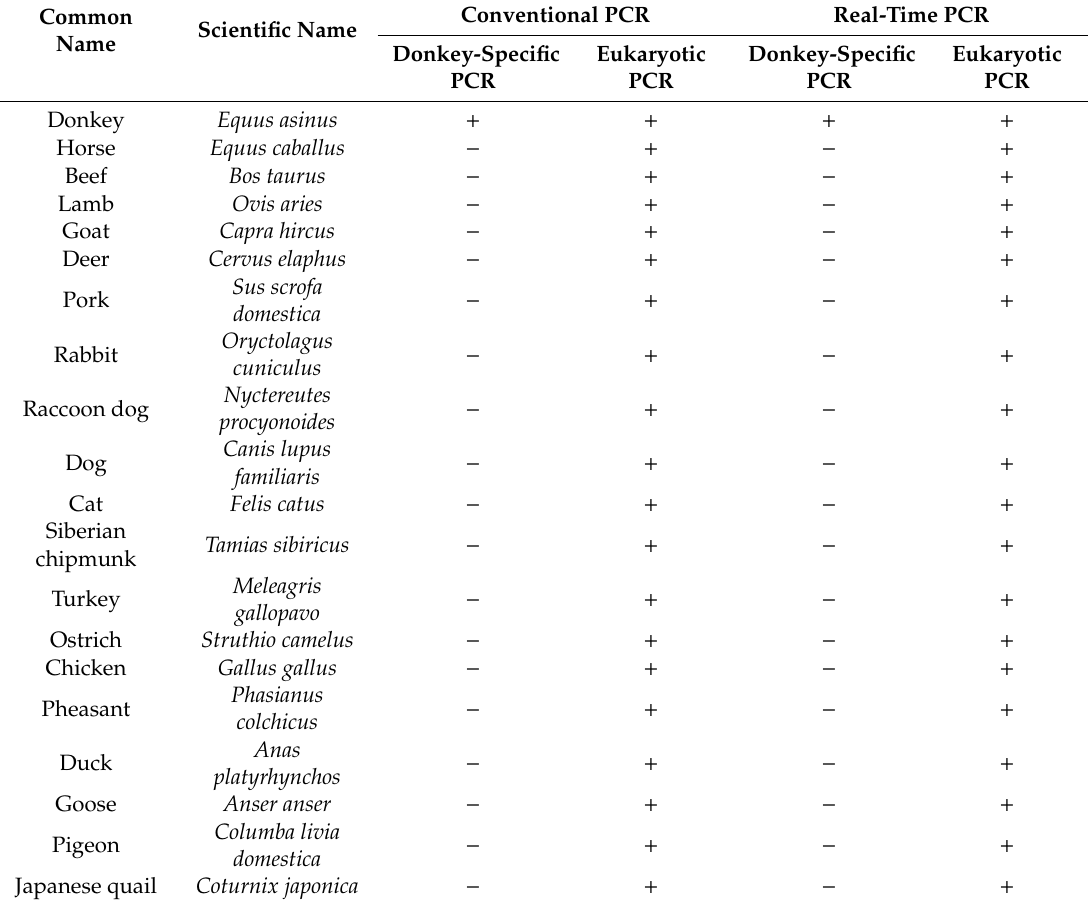
Table 2. Specificity results using conventional and real-time PCR